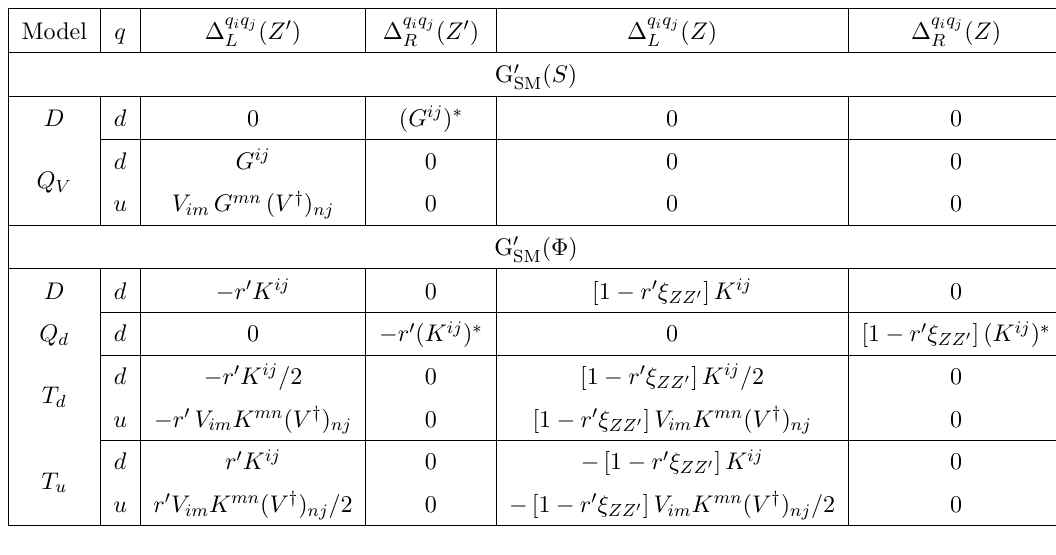
Table 4. (cid:1) q i q j ( Z 0 ) and (cid:1) q i q j ( Z ) for down- and up-type quark couplings ( i; j = 1 ; 2 ; 3) in G 0 L;R L;R models. Here V ij is the CKM matrix.